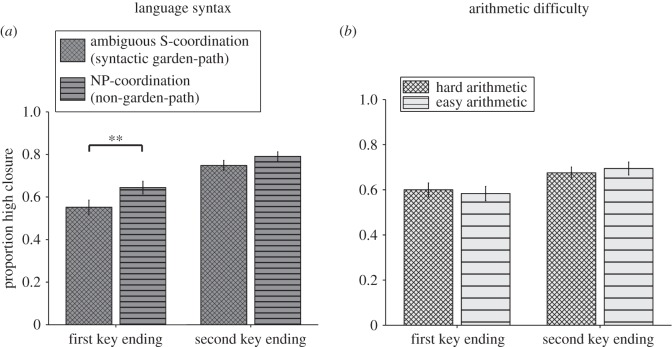
Experiment 1: closure ratings of critical trials. Participants were asked to rate their feeling of closure, i.e. completeness (y-axis), of harmonic sequences ending either in a way typical for a first established key or in a second-key-typical way (x-axis). Different bars represent concurrent task conditions. (a) In one block people solved the auditory music task while they were also asked to read sentences. We found an influence of language syntax on music harmony ratings. (b) In a different block, people solved the auditory task while they also performed an arithmetic task. The arithmetic manipulation was without effect. Significance levels represented as stars refer to simple main effect t-tests and do not imply significant interaction effects. Error bars=s.e.m. **p<0.01.